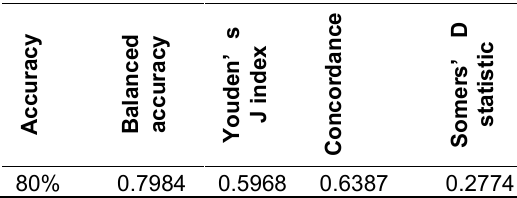
Table 3. Evaluation metrics of